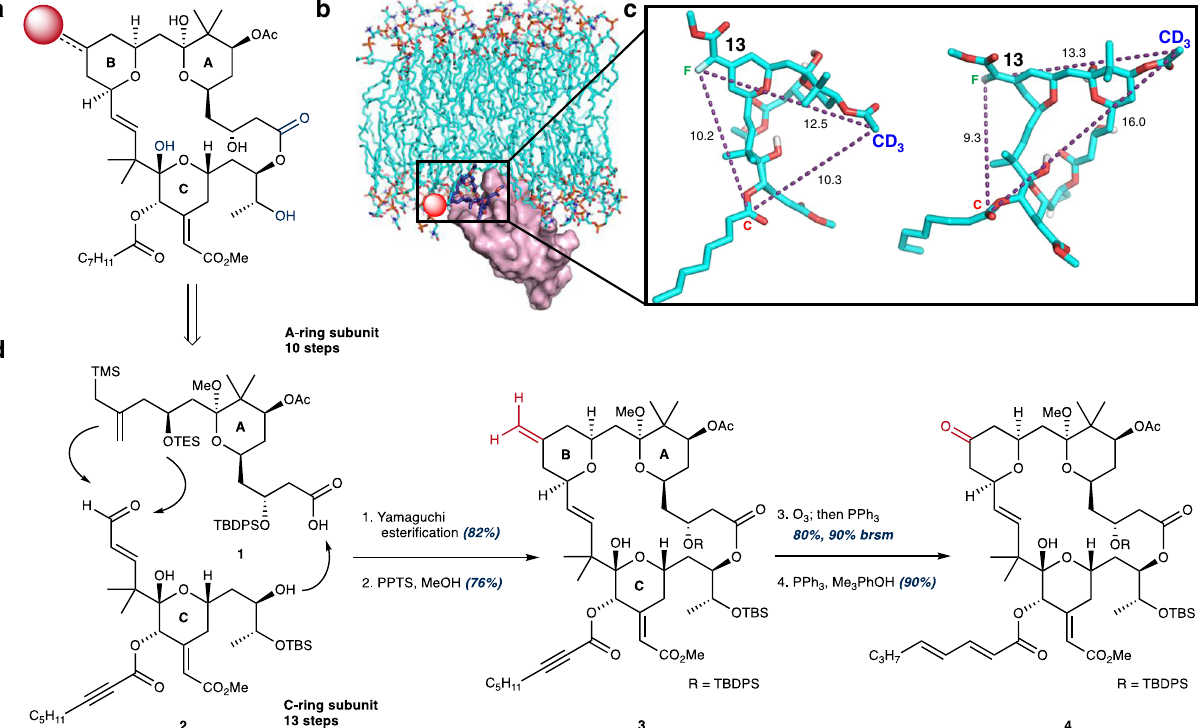
Fig. 1 FOS design strategy for the synthesis of bryostatin analogs. a Retrosynthetic analysis of the bryostatin scaffold with key pharmacophoric elements highlighted in blue (C1 carbonyl, C19 hemiketal, C26 alcohol). C13 (red sphere) highlighted as a diversi fi cation node for analog synthesis. b Rendering of the PKC-bryostatin-membrane ternary complex. Bryostatin 1 shown in dark blue. Pharmacophoric elements of the C-ring subunit of the bryostatin scaffold ( a ) interact directly with PKC (purple) while the A and B rings are imbedded in the plasma membrane (cyan). Adapted with permission from Yang et al. (https://pubs.acs.org/doi/full/10.1021/acscentsci.7b00475) and the American Chemical Society (ACS) 56 . Further permissions related to the material excerpted should be directed to the ACS. c Representative conformers of the bryostatin scaffold bound to PKC that fi t experimentally determined intramolecular distances determined by REDOR NMR. Adapted with permission from Yang et al. (https://pubs.acs.org/doi/full/10.1021/ acscentsci.7b00475) and the ACS 56 . Further permissions related to the material excerpted should be directed to the ACS. d Convergent construction of the bryostatin scaffold from acid 1 and enal 2 . C13 functionality (highlighted in red) provides a versatile functionalization node for late-stage diversi fi cation, avoiding interference with the pharmacophoric elements of the C-ring (highlighted in blue, a